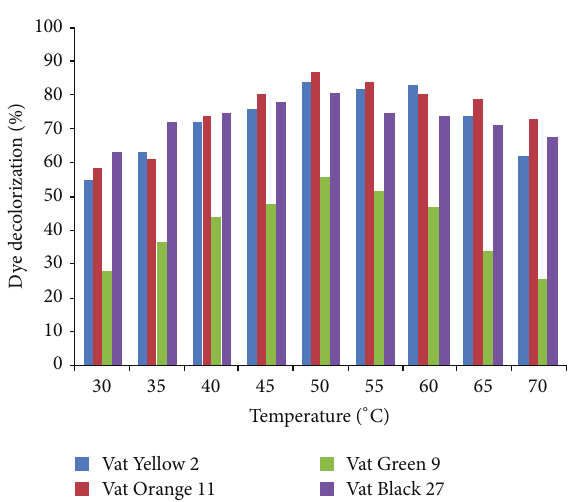
Figure 10: Effect of temperature on dye decolourization with garlic peroxidase.